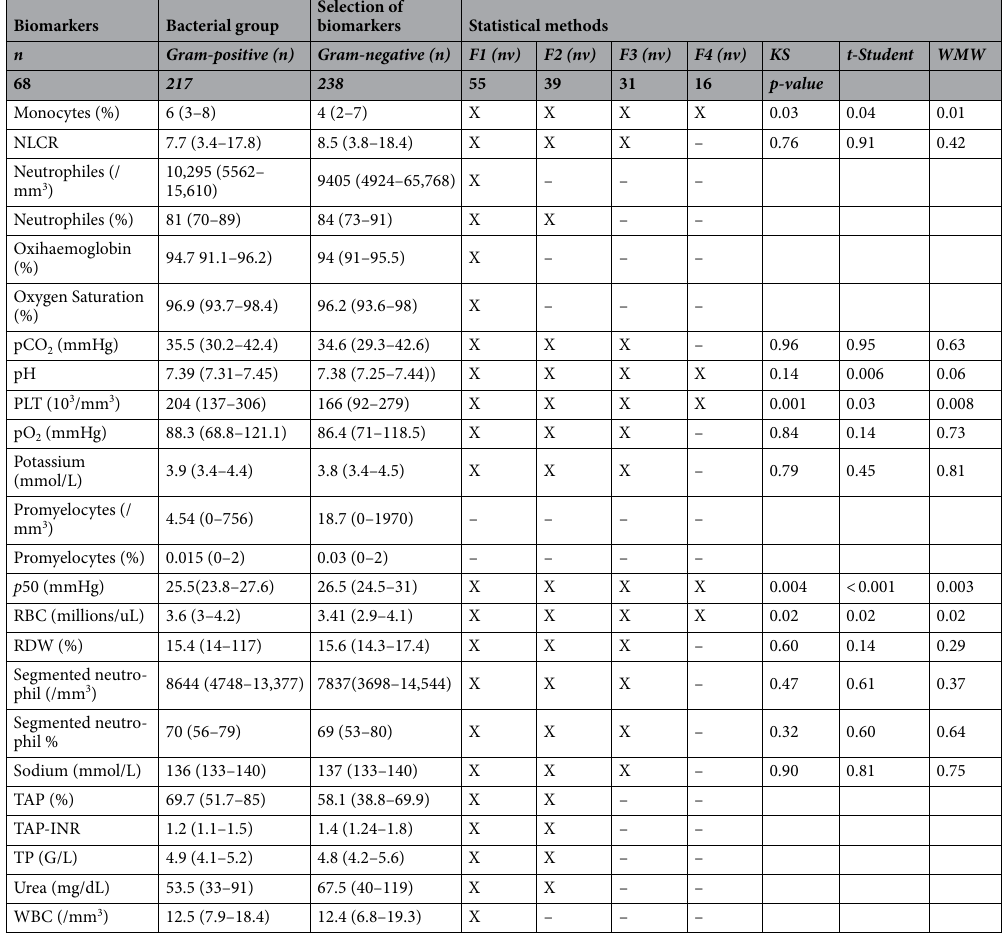
Table 3. Characteristics of all patients and laboratory biomarkers analyzed. X: selected biomakers; –: non selected biomakers; n = number of samples; nv = number of variables. Data given as mean with interquartile range (Q1, Q3). KS two-sample Kolmogorov–Smirnov test, t-Student Two-Sample t-Student test, WMW Two Sample Wilcoxon Signed Rank Test, ALAT alanine aminotransferase, aPTT activated partial thromboplastin time, ASAT aspartate aminotransferase, Left shift (bands + metamyelocyte + myelocyte + promyelocyte + blasts), CO 2 carbon dioxide, CRP C-reactive protein, ctO 2 oxygen contend, HCO 3 sodium bicarbonate, MCH mean corpuscular haemoglobin, MCV mean corpuscular volume, MCHC mean corpuscular